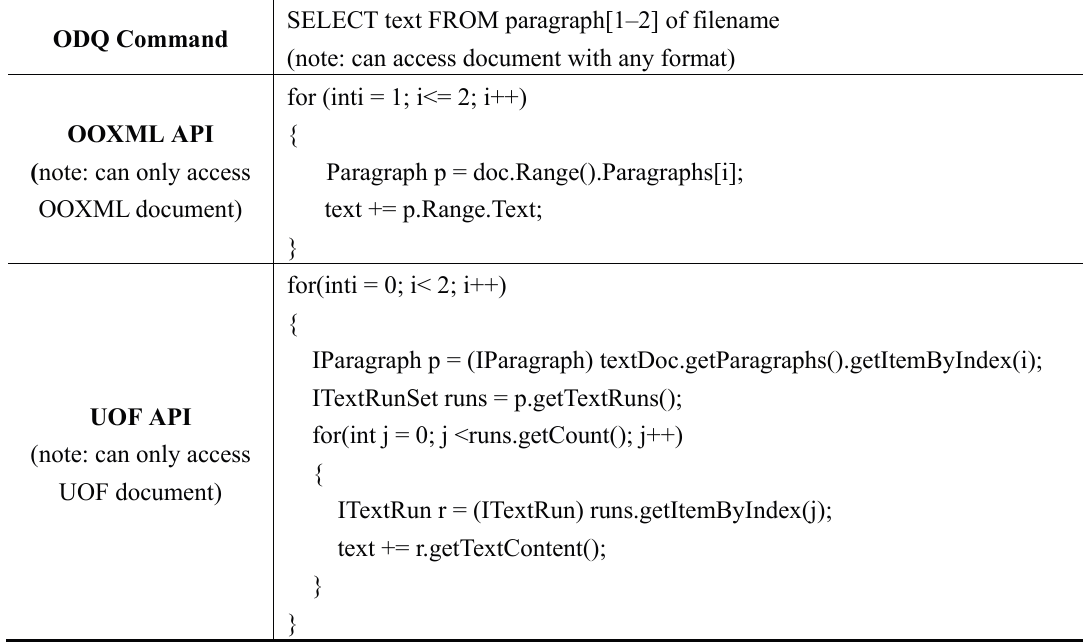
Table 2. Comparison of code to fetch text of the first two paragraphs by three